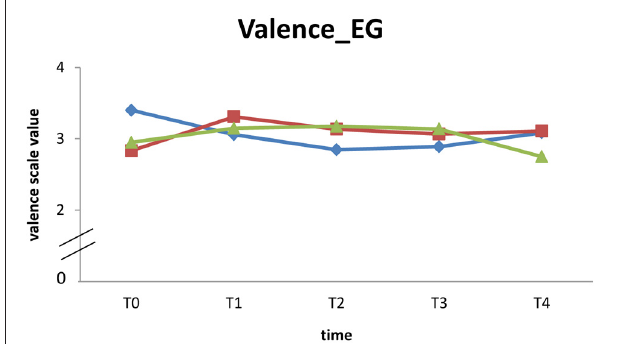
FIGURE 2 | Individual trend of valence from T0 to T4 of participants ( EG ) with good compliance.